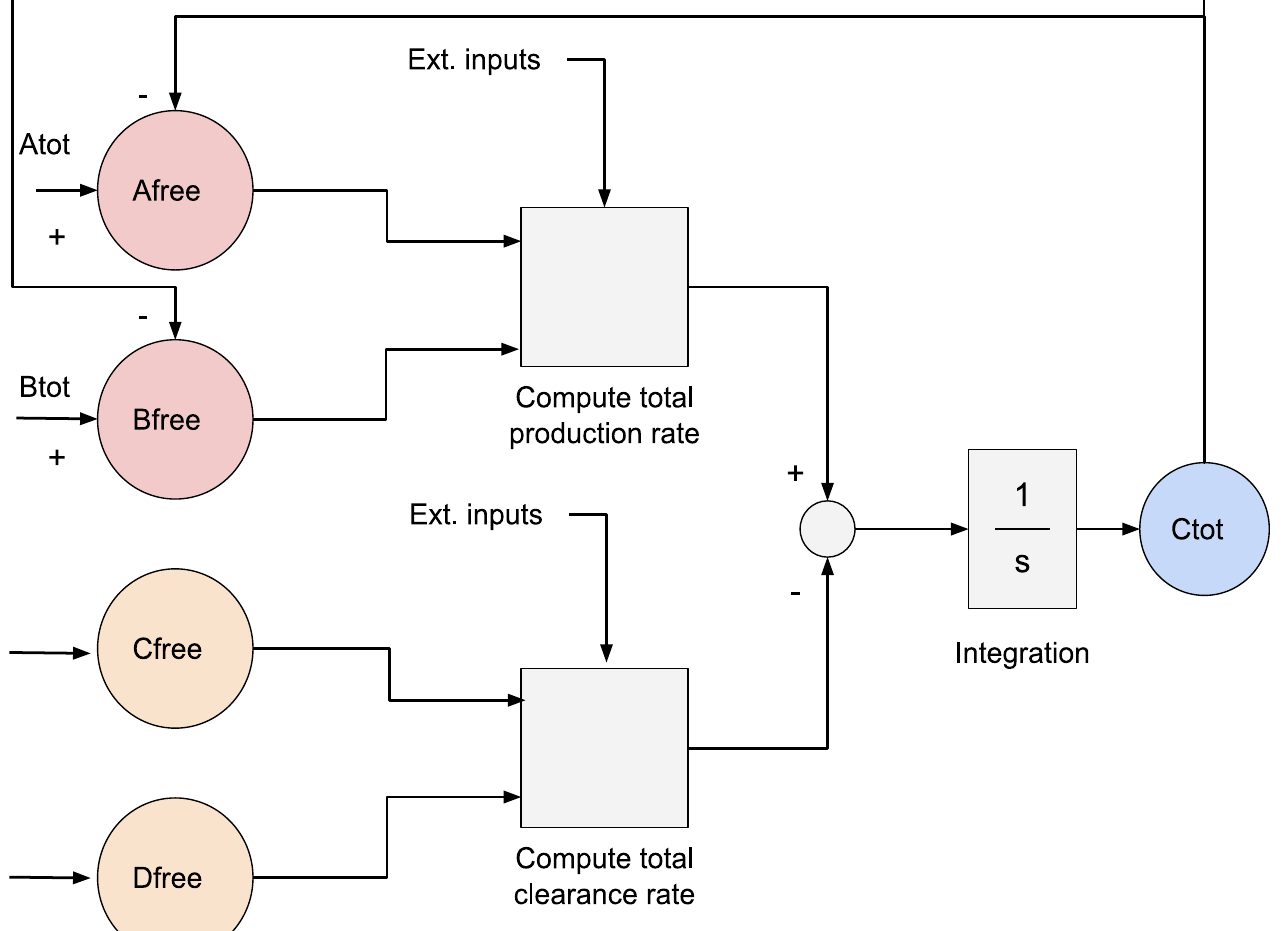
Fig 3. A flow diagram for the cytomorphic compiler. The compiler processes the input SBML model to “expand” (see below) lumped kinetic expressions into constituent bimolecular elementary processes. Elementary reactions are then mapped to blocks on the chip (sometimes to multiple blocks, as in fan–out reactions described below). Each block is assigned parameter values based on the forward and reverse rate constants of its respective reaction, and potentially degradation of the product. Blocks are connected together based on the topology of the reaction network, but care must be taken to maintain a single “total” value for each species, as described in the “Network Building Blocks” section. The final output of the compiler is a configuration for the shift registers (which store parameter values) for all used blocks and SRAM (which connects block input and output ports).